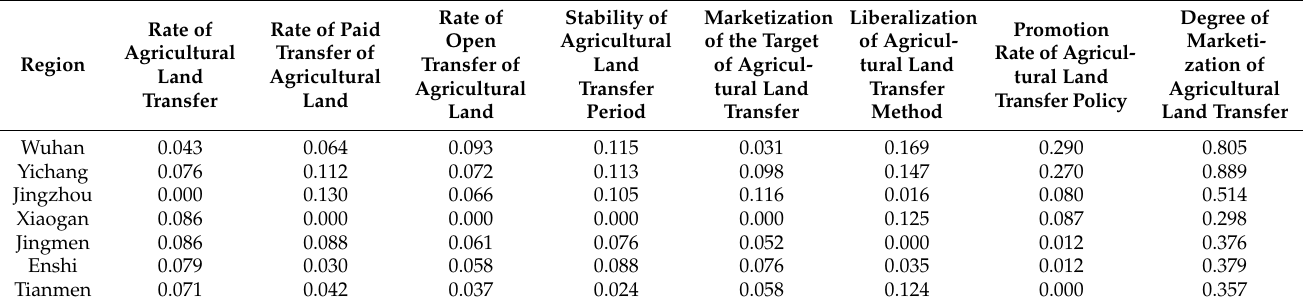
Table 5. Evaluation results of the degree of marketization of agricultural land